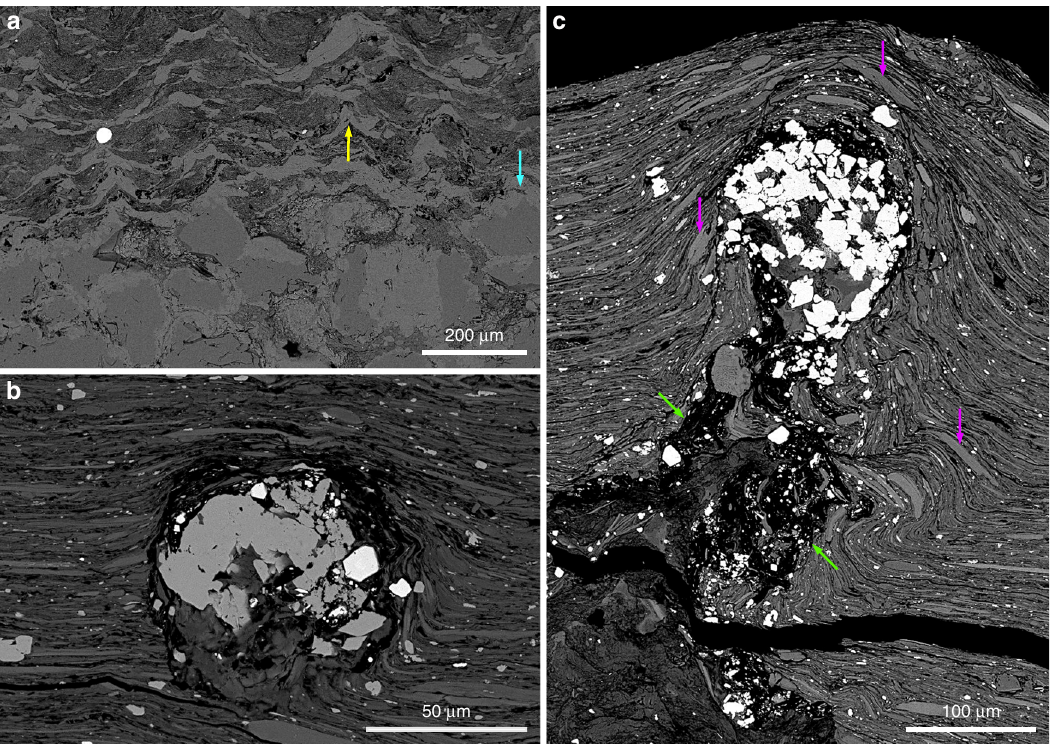
Fig. 2 Biogenetic fabrics in the mat-related structures. The MRS textures are shown through SEM images. a Tufted microbial fabrics developed above the poorly-sorted quartz sandstone. Yellow and blue arrows point to tufts and quartz grains, respectively. b A void- fi lling titanium oxides that may have fi lled an oxygen bubble produced within the microbial mat. c Nearly-circular void fi lled with titanium oxides at the tip of a cone-like feature (green arrows) Detrital dioctahedral micas (e.g., muscovite) are shown by purple